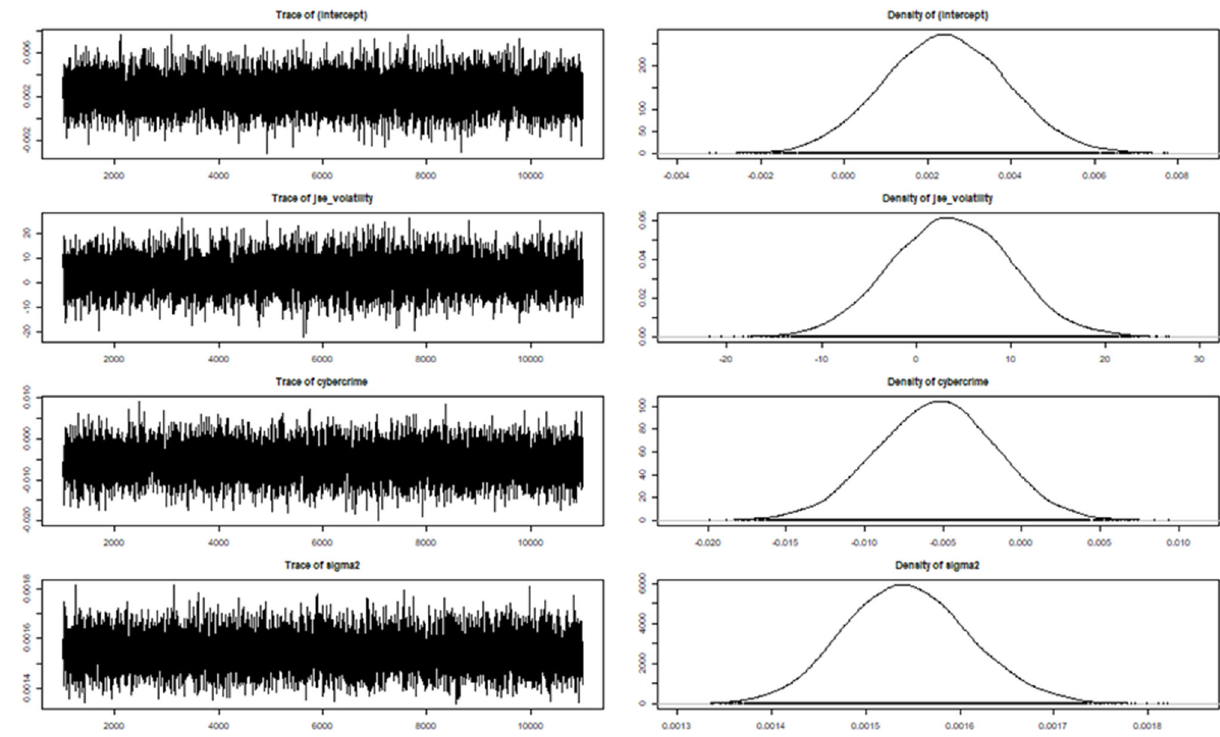
Figure 8. Posterior distribution of the variables with return on Bitcoin as dependent variable.